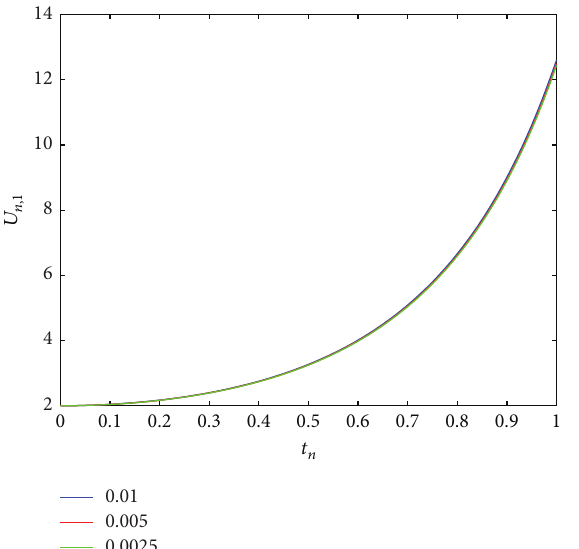
Figure 4: The solution of (48) by the repeated trapezoidal rule. 4.1.5. Using Repeated Simpson’s Rule. When 𝑡 = 0 , 𝑢(0) = 2 for (48) and